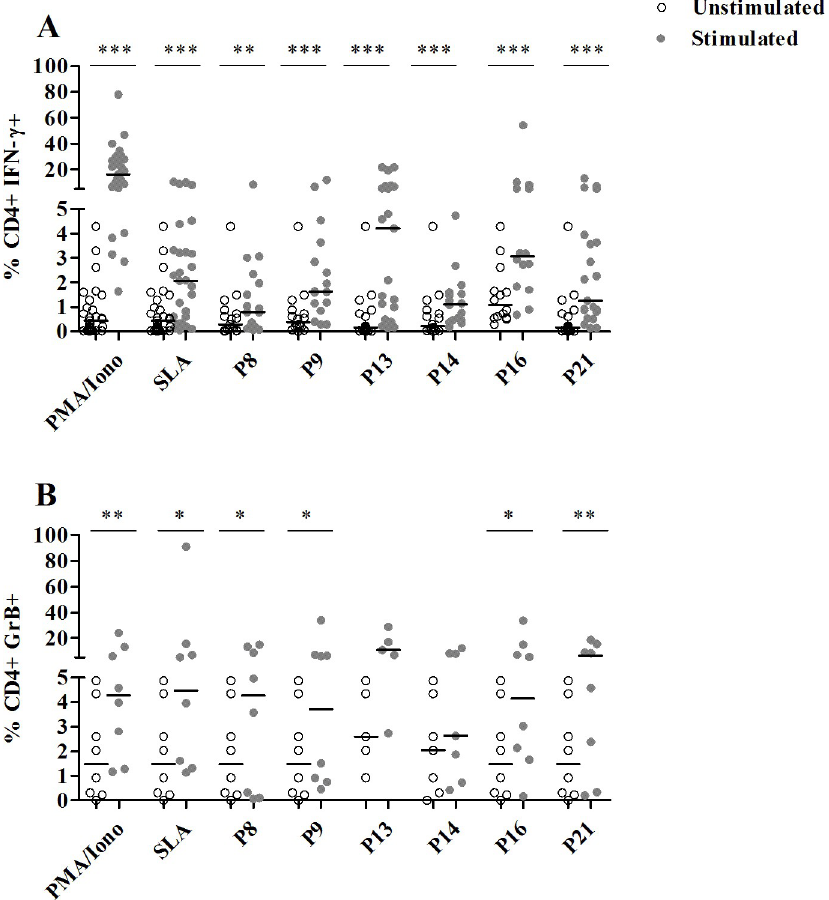
Fig 8. Percentages of CD4+ T cells producing IFN- γ or GrB in response to selected multi-epitope peptide pools. PBMC from cured CL subjects, previously stimulated with selected peptide pools (1 μ M/peptide) for 10 days, were re- stimulated overnight with the same peptide pools (1 μ M/peptide) and with anti-CD49d/anti-CD28 antibodies (1 μ g/ ml). For intracellular IFN- γ (N = 21 cured individuals) and Granzyme B (N = 9 cured individuals) detection, cells were treated with Golgistop for 6 h of culture, fixed and permeabilized using BD Cytoperm/cytofix kit. Data were analyzed by FlowJo software. PBMC stimulated with PMA (50 ng/ml)/Ionomicyn (10 –6 M) for 6 h or SLA (10 μ g/ml) for 5 days, were used as positive control. Results represent the frequency of CD4+ IFN- γ + (A) and CD4+ granzyme B+ (B) T cell populations. Horizontal bars represent median values. Statistical significance was assigned to a value of p < 0,05 ( � p < 0.05, �� p < 0.01, ��� p <